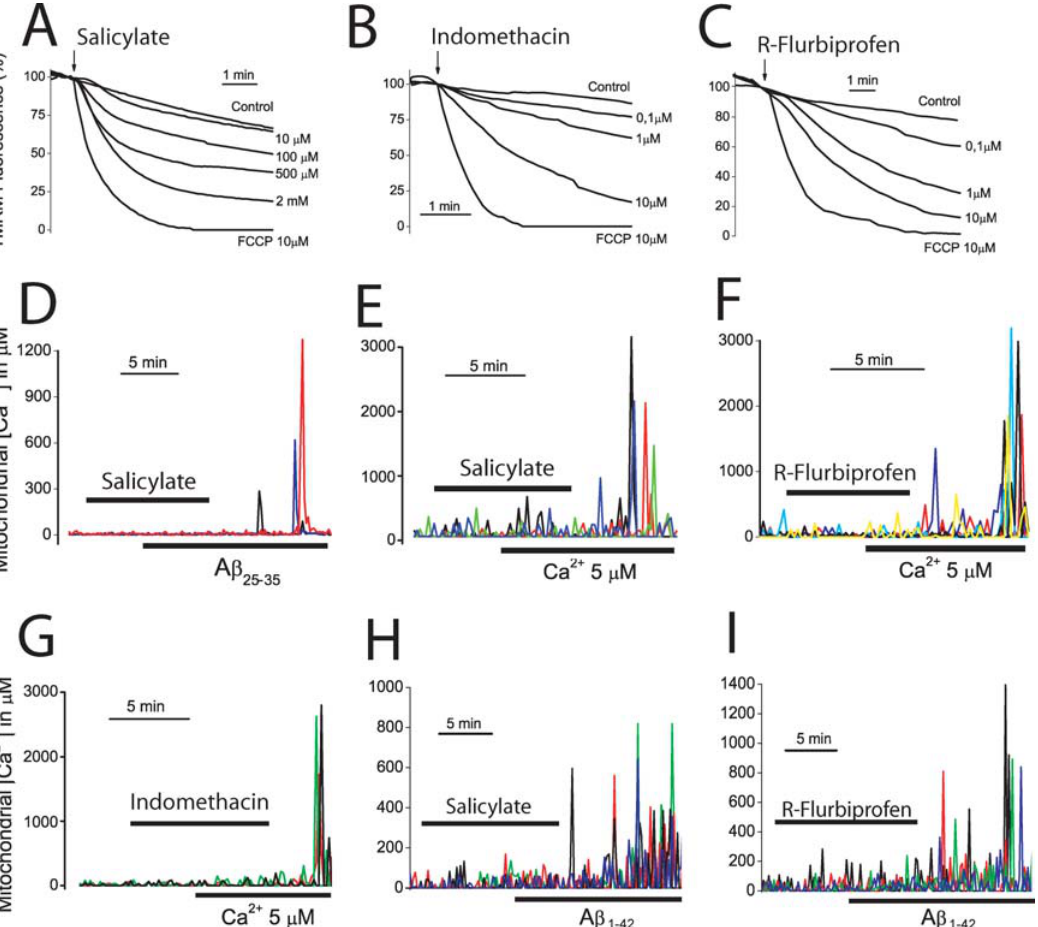
Figure 6. NSAIDs depolarize mitochondria and inhibit mitochondrial Ca 2 + uptake. A–C . Cerebellar granule cells were stained with 10 nM TMRE and subjected to fluorescence microscopy for monitoring changes in mitochondrial potential. Each trace correspond to averaged, normalized fluorescence values of 34–42 cells treated (arrow) with vehicle (control) or different concentrations of salicylate (A, 10 m M to 2 mM), indomethacin (B, 0.1 to 10 m M), R-flurbiprofen (C, 0.1 to 10 m M). FCCP 10 m M was also added to compare with conditions of collapse of the mitochondrial potential. Each series of recordings is representative of at least 3 experiments. D–F . Cerebellar granule cells were transfected with the mGA plasmid and subjected to bioluminescence imaging for monitoring [Ca 2 + ] mit . Salicylate (D, 100 m M) inhibits the [Ca 2 + ] mit induced by A b 25–35 (20 m M, n=43 cells, 3 experiments). In some experiments, cerebellar granule cells expressing mGA were permeabilized in intracellular medium containing 200 nM Ca 2 + (see methods) and treated with salicylate 100 m M (E), R-flurbiprofen 1 m M (F) or indomethacin 1 m M (G) before being stimulated with the same intracellular medium containing 5 m M Ca 2 + to stimulate mitochondrial Ca 2 + uptake (Data from 188 cells studied in 6 independent experiments). H,I. Salicylate 100 m M and R-flurbiprofen 1 m M also inhibits the increase in [Ca 2 + ] mit induced by A b 1–42 oligomers (500 nM). Data from n=35 and 30 cells respectively, studied in 3 independent experiments for each drug.